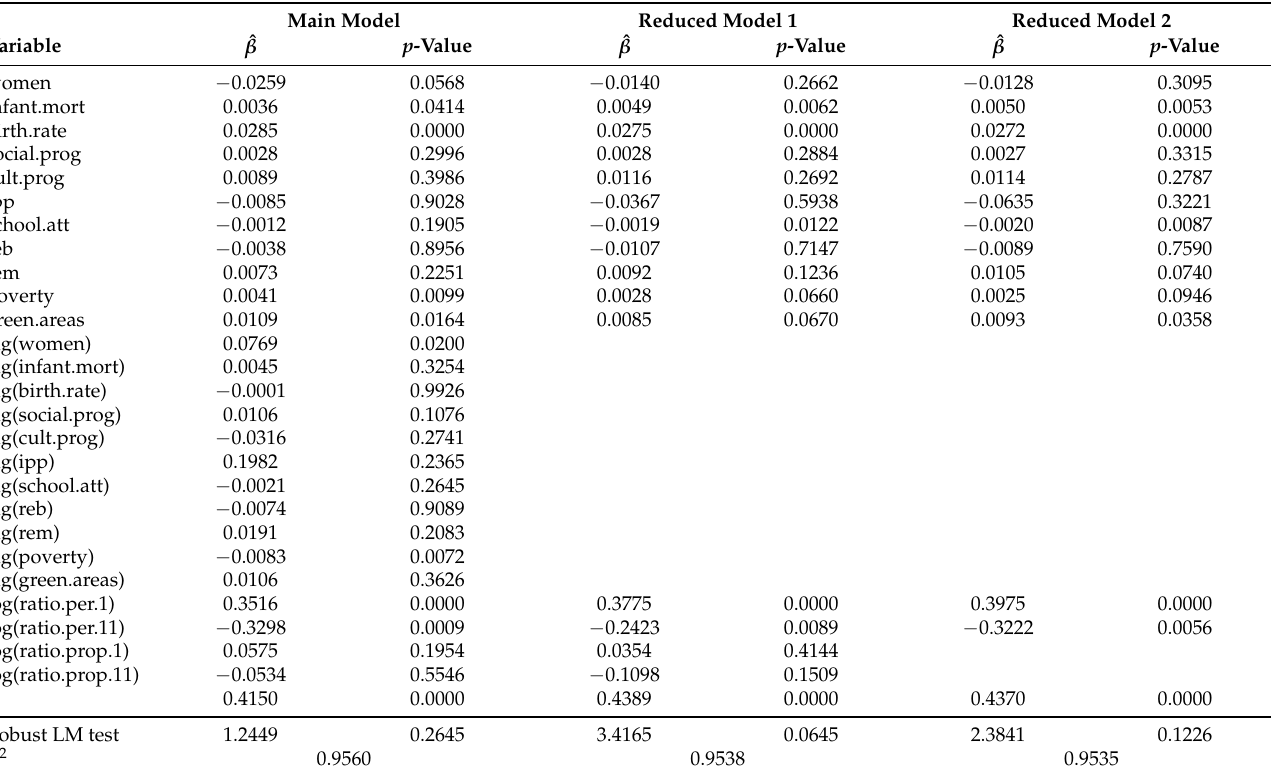
Table 6. Estimation of spatial panel